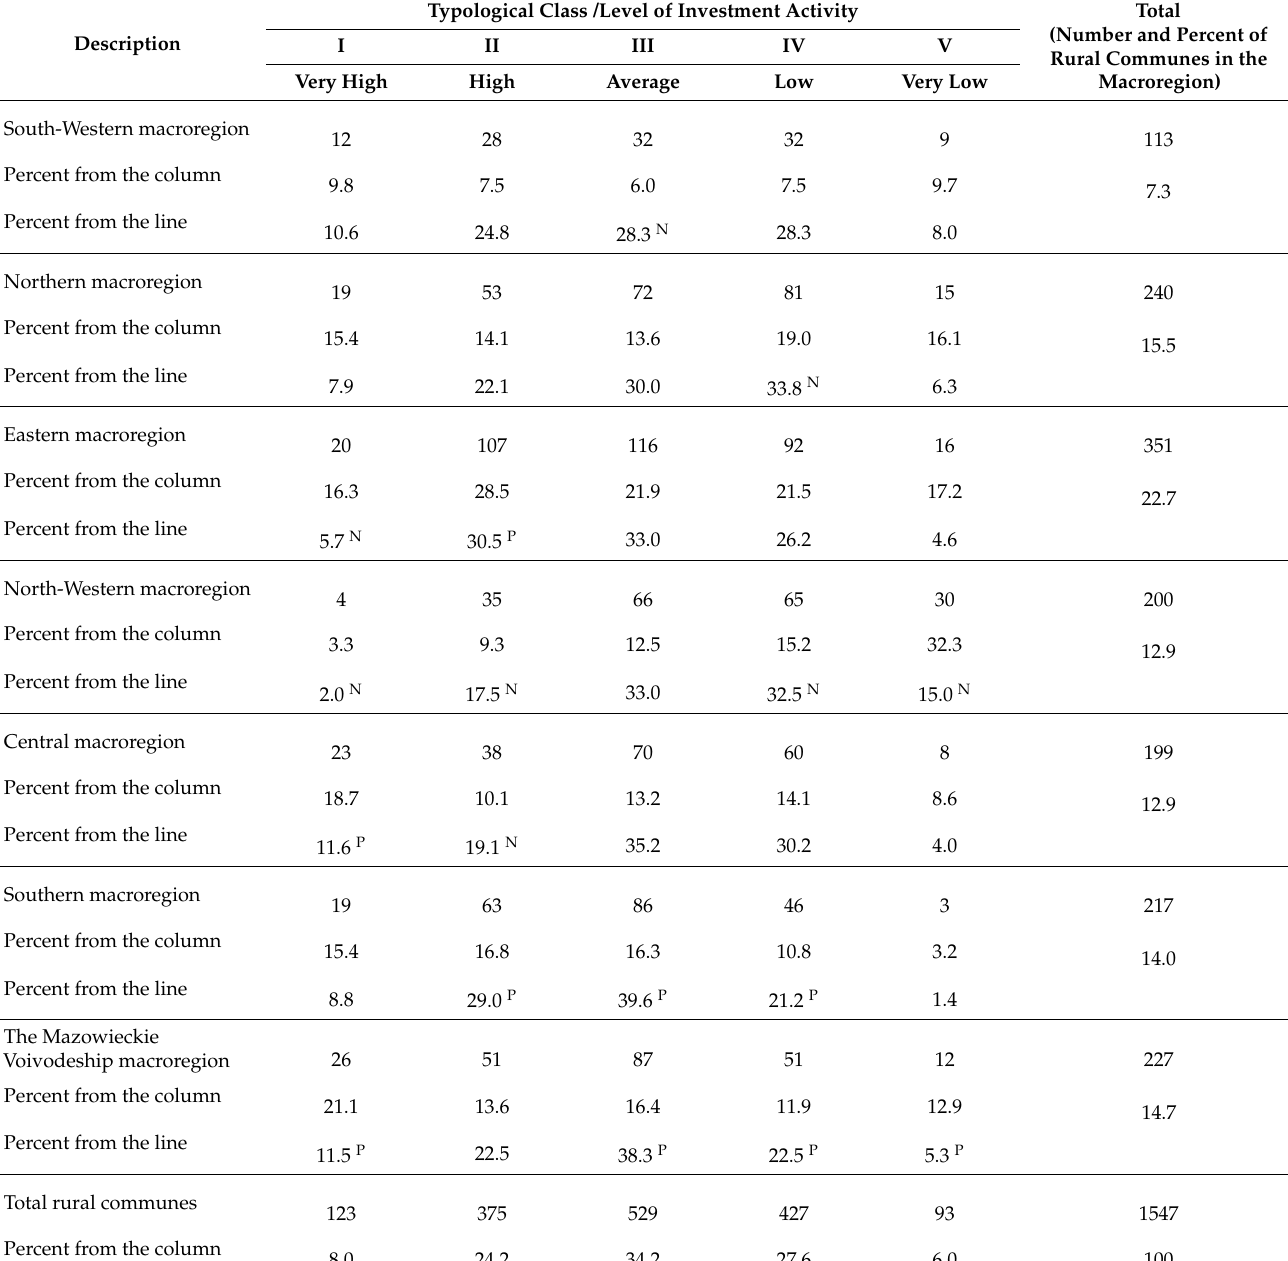
Table 5. Rural communes by macroregion arranged in terms of typological classes of investment activity level in Poland in the years 2007–2018 a